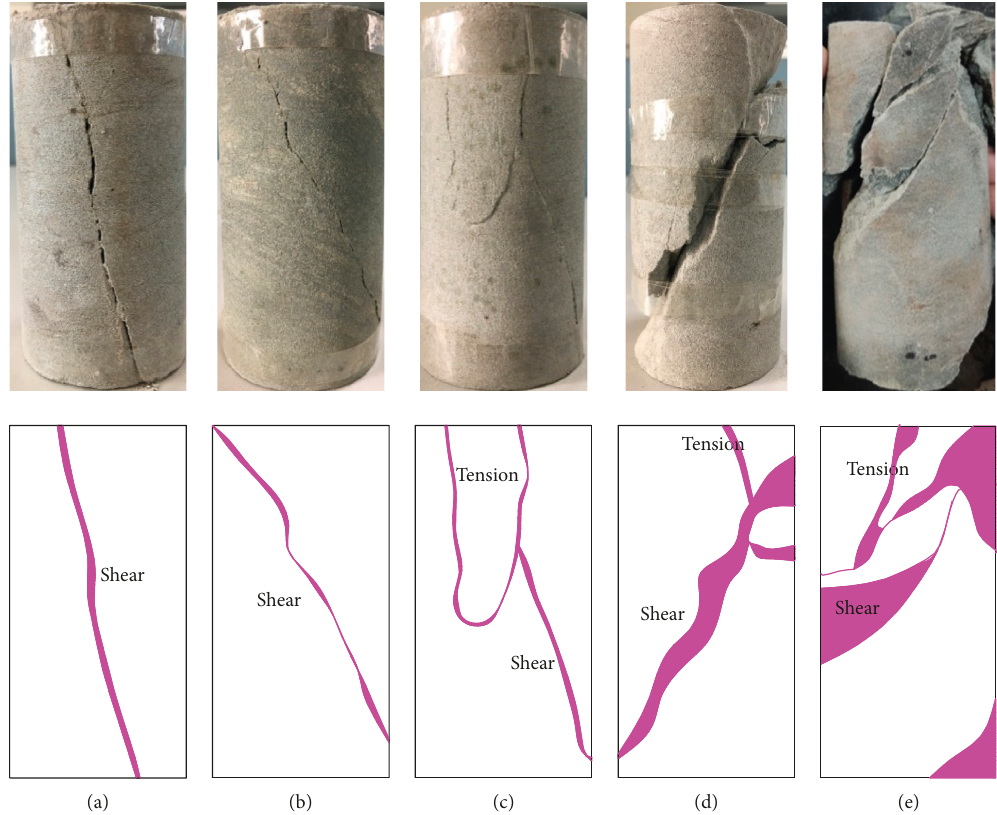
Figure 11: Failure characteristics of PD rock. (a) S-0 rock sample. (b) S-1 rock sample. (c) S-2 rock sample. (d) S-3 rock sample. (e) S-4 rock